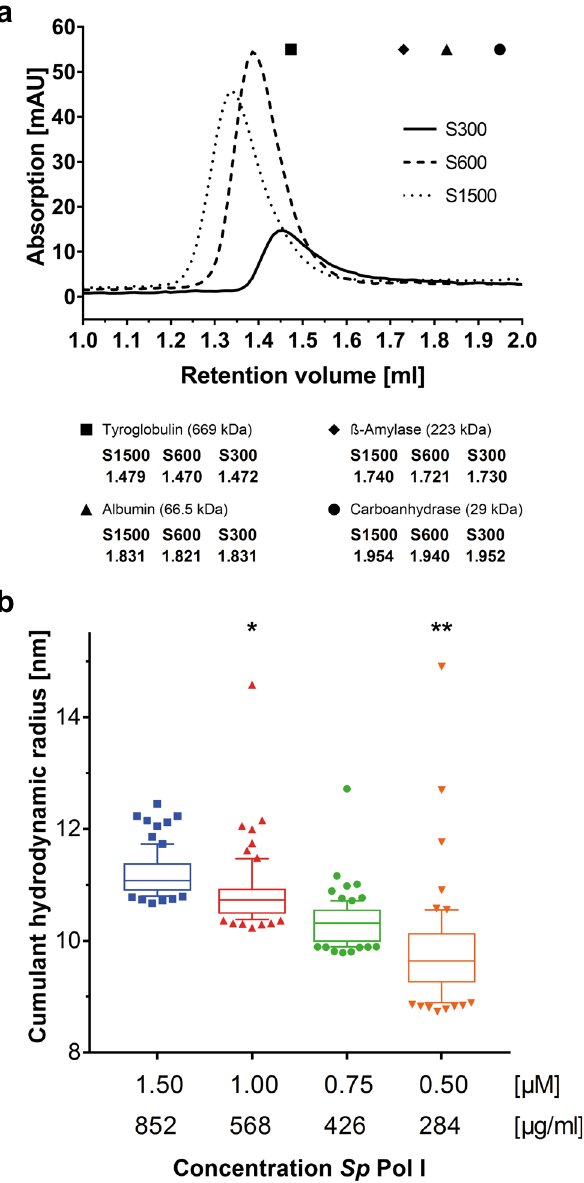
Fig. 2 Sp Pol I can dimerize in vitro dependent on protein concentration and buffer condition. a Analytical Size Exclusion Chromatography (SEC) of Sp Pol I in buffers containing 1500mM (S1500; dotted), 600mM (S600; dashed) or 300mM (S300; continuous) Potassium Acetate. The main peak (A 280nm ) elutes at higher apparent molecular weight in the high salt buffer. The average elution peaks of reference proteins are indicated: black square – Tyroglobulin; Black diamond – ß-Amylase; Black triangle – Albumin; Black dot – Carboanhydrase (exact retention volumes at the bottom). Compare Sup. Fig. 5 for negative-stain EM characterization of S300 and S1500 peak fractions and methods for details. b Dynamic Light Scattering (DLS) analysis of Sp Pol I particles (S600 buffer) measured using the Panta technology (Methods). Each mark represents an individual measurement ( n = 80 for each Pol I concentration). At higher Pol I concentration, the hydrodynamic radius of particles in solution increases, indicating a shift of equilibrium towards dimerization. The boxes show the median (horizontal line inside box) and span from the 25 th to the 75 th percentiles, the whiskers reach up to the 90 th and down to the 10 th percentile, measurements beyond these are shown as individual points (* one outlier at 32.72nm is not displayed; ** two outliers at 19.98nm and 21.04nm are not